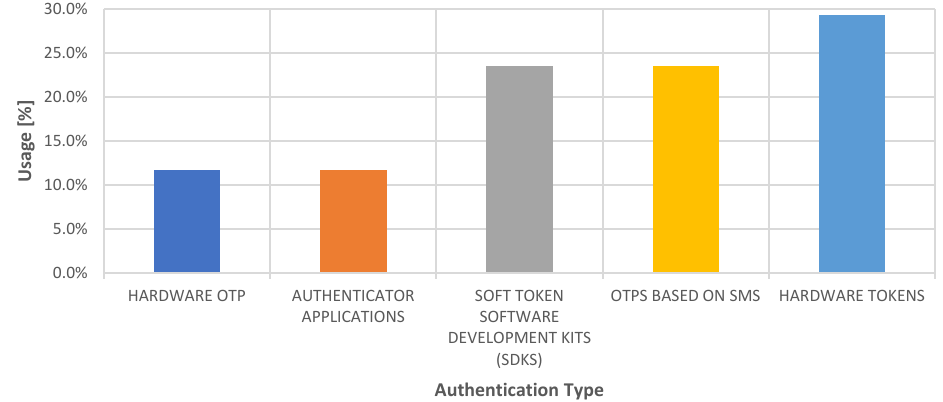
Figure 6. Trends in different authentication types to enable MFA.